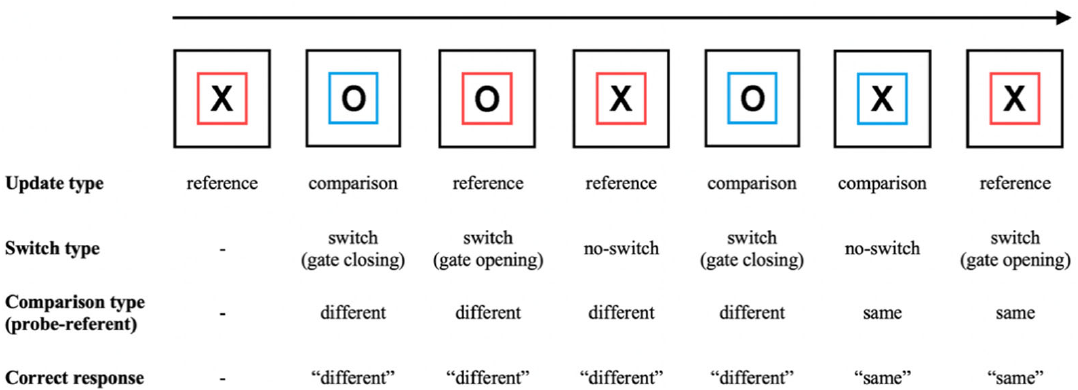
Figure 1. Illustration of the reference-back task. In each trial, subjects indicate whether the probe stimulus (‘X’ or ‘O’) is the same as or different to the stimulus in the most recent red frame (the WM referent). In reference (red frame) trials, subjects must update WM with the currently displayed probe item. In comparison (blue frame) trials, subjects make the ‘same/different’ decision but do not update WM. Comparing behavior (e.g., accuracy, RT) between different trial types measures the costs of several WM control processes (see the main text and Table 1 for details).